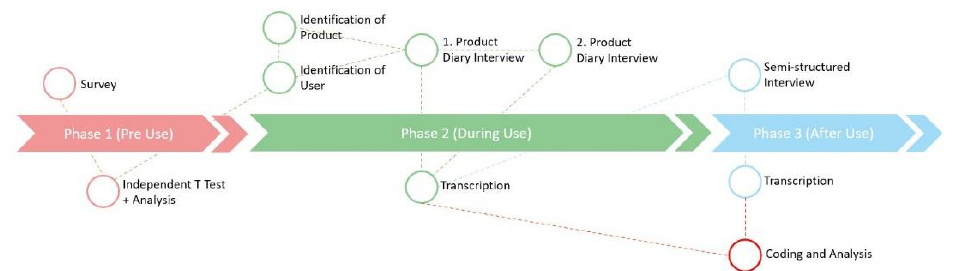
Figure 4. Summary of the methodology.